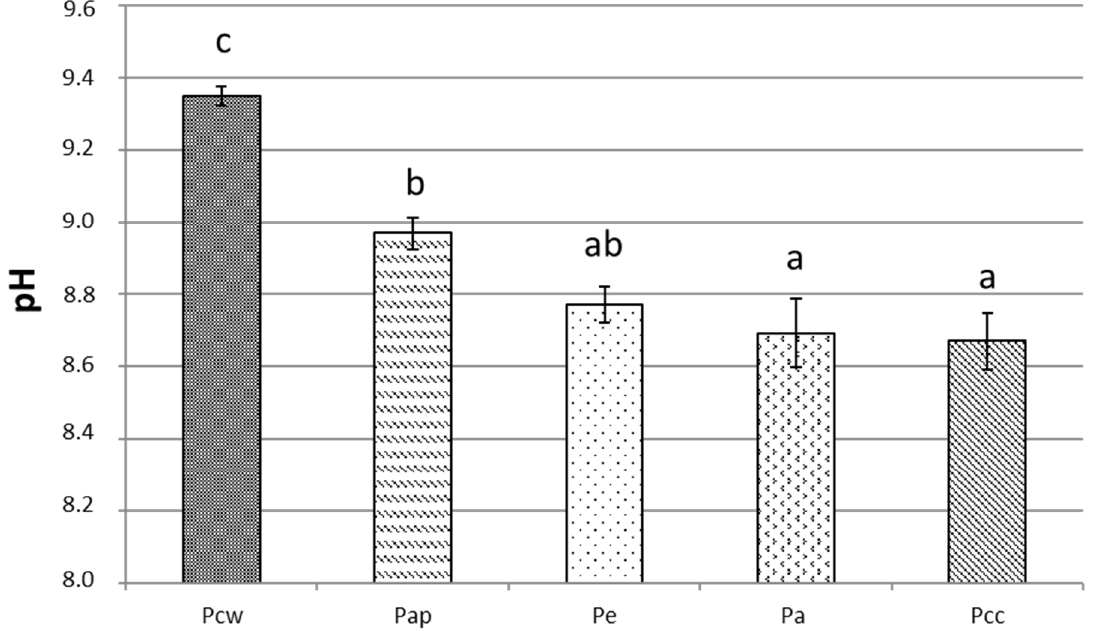
Figure 5. Average media acidification by roots of plantlets belonging to four interspecific Pyrus hybrids (Pa, Pap, Pcc, Pe) and open pollinated Pyrus communis ‘Williams’ (Pcw) under in vitro iron deficiency conditions. Since no significant interaction was observed between NaHCO 3 and Pyrus species ( p = 0.676), mean values come from the measures of 32 replicates per genotype. Bars represent the standard error. Hybrids with different letter are significantly different (Tukey, p < 0.05).